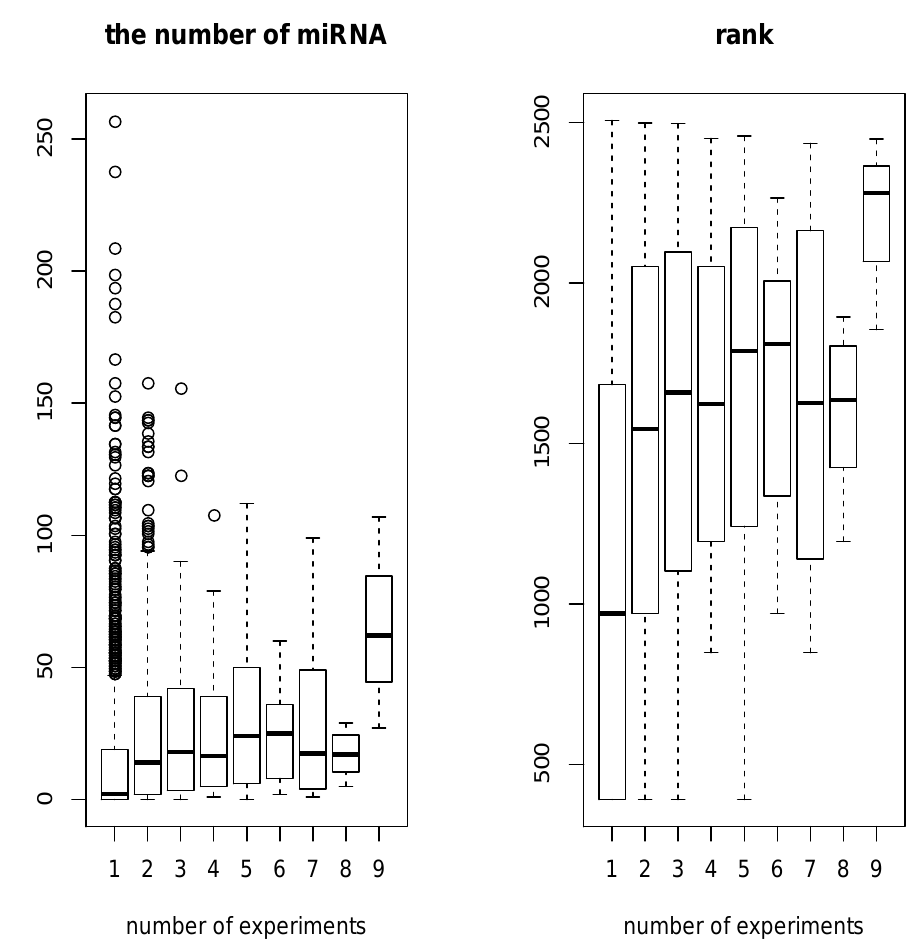
Figure 3. A boxplot of the number of miRNAs that target individual genes as a function of the number of experiments that select individual genes within 11 experiments (most frequently selected genes were selected in nine experiments): ( Left ) raw numbers (Pearson’s correlation coefficient = 0.13, P = 3.9 × 10 − 11 ); and ( Right ) ranks of numbers (Spearman’s correlation coefficient = 0.29, P < 2.2 × 10 − 16